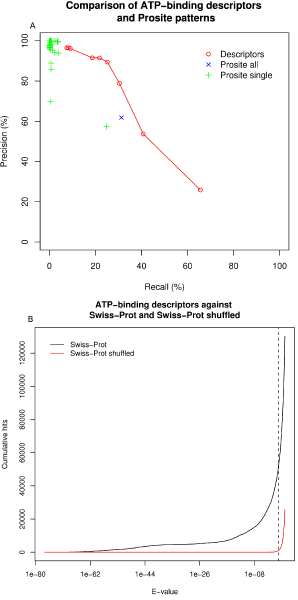
Assessing accuracy and significance of ATP-binding descriptors. A. Precision-recall curve for ATP-binding descriptors derived from protein structures with bound ATP or ADP tested against Swiss-Prot, shown as curve with red circles. Each circled point corresponds to a different E-value cutoff. The Prosite patterns for "ATP-binding" and "ADP-binding" are included as well (green crosses). Overall, Prosite achieves a recall of 31% with a precision of 62% (blue cross). For all E-values, our method performs better than Prosite. B. Distribution of E-values for the ATP-binding descriptors. To assess the significance of hits, the descriptors were tested both against Swiss-Prot (black line) and a shuffled Swiss-Prot version (red line). The cumulative number of hits below a certain E-value threshold is shown. The inlet shows a magnification of the lower right corner. Below an E-value of 1 (dotted vertical line), ~53,000 hits are found in Swiss-Prot whereas only ~1,200 hits are found in the shuffled Swiss-Prot.